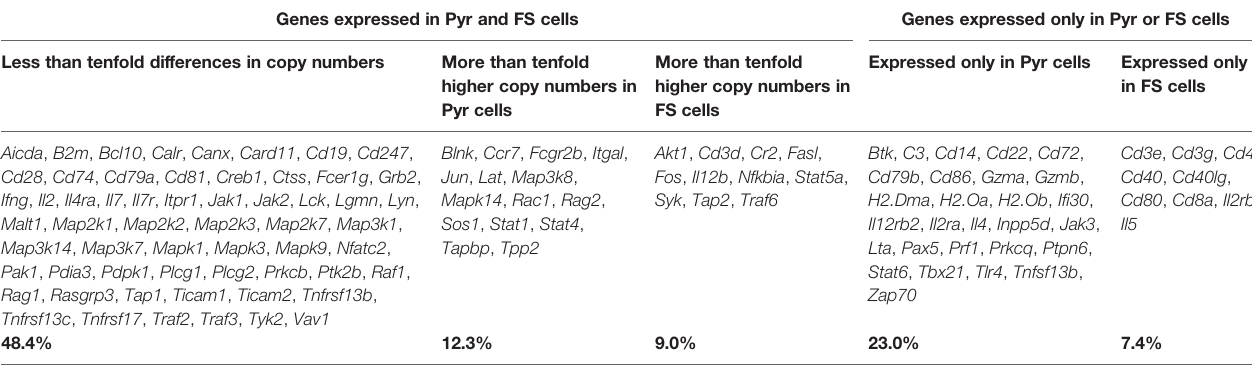
TABLE 2 | The cell type distribution of transcripts encoding proteins of immune cell